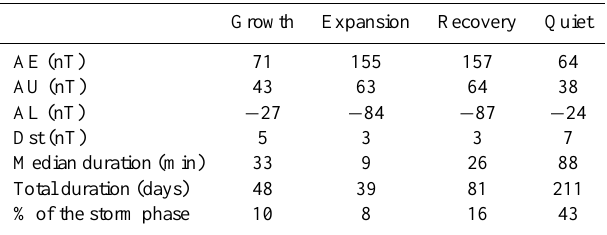
Fig. 4. Annual distribution of total duration of storm phases and non-storm times (top) and substorm phases and quiet times (bot- tom). Initial and growth phases are green, main and expansion phases red, recovery phases blue and non-storm and quiet times black. The vertical dotted lines mark the solar minimum years (blue) and solar maximum year (red). Table 3. Median values of substorm phases during storm initial phases.